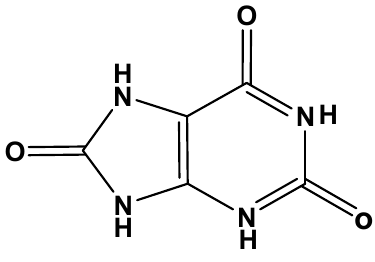
Figure 1. Chemical structure of uric acid.